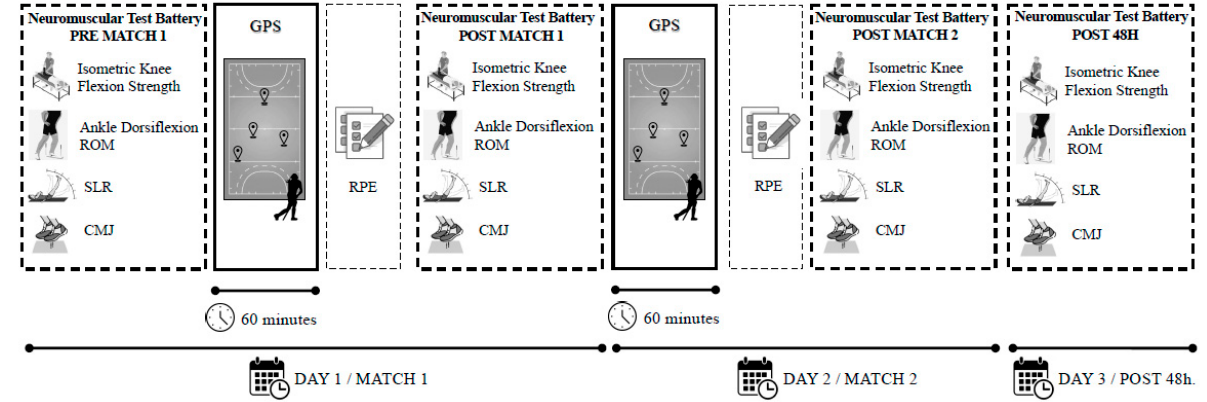
Figure 1. The experimental protocol used in the study.